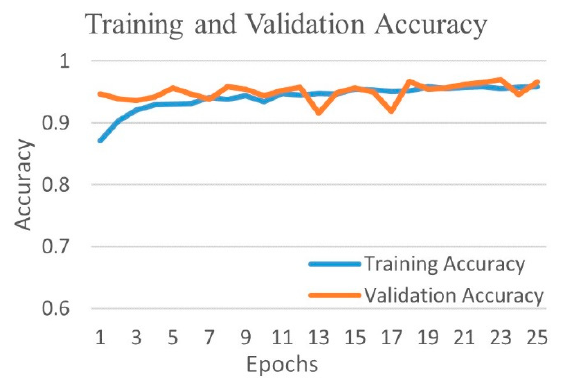
Figure 16. Training and validation accuracy of best performing VGG16 model for three-class experiment.